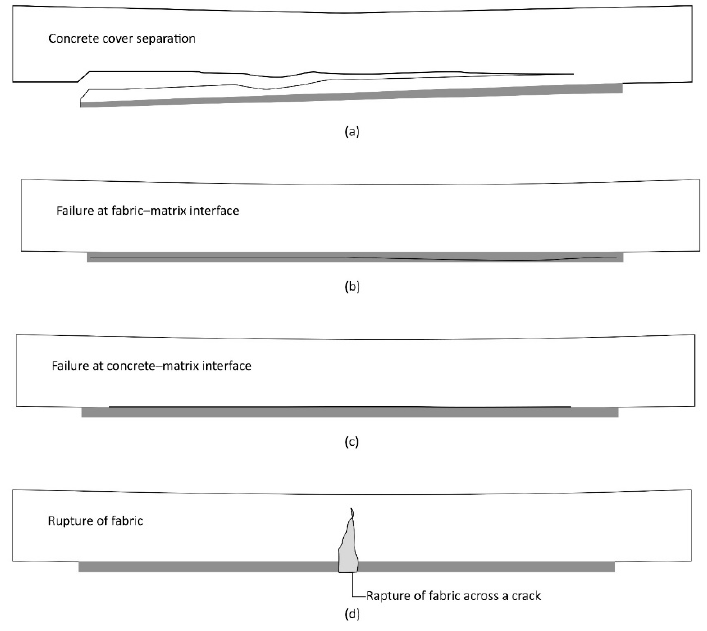
Figure 5. Illustration of failure modes.